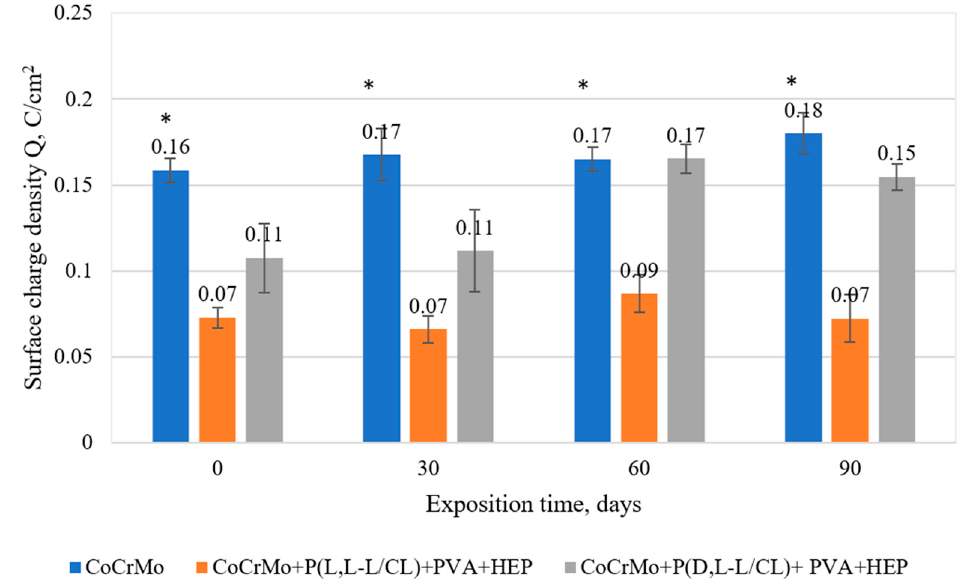
Figure 7. Comparison of mean values of electric flux density determined in potentiostatic studies for the tested variants of CoCrMo alloy surface modification, with exposure time to artificial urine up to 90 days (* p < 0.05 versus the control group).